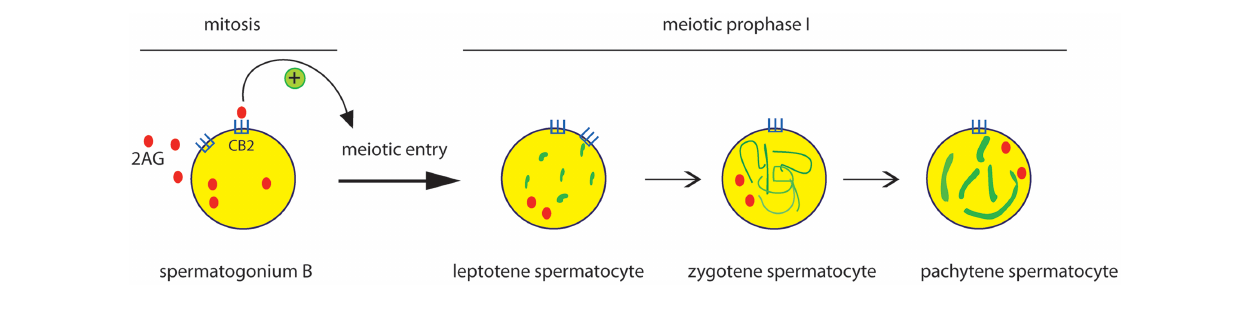
promotes meiotic entry and progression of spermatogonia, as revealed by the meiotic organization of nuclear SCP3 (green) during the prophase I phases (leptotene, zygotene,